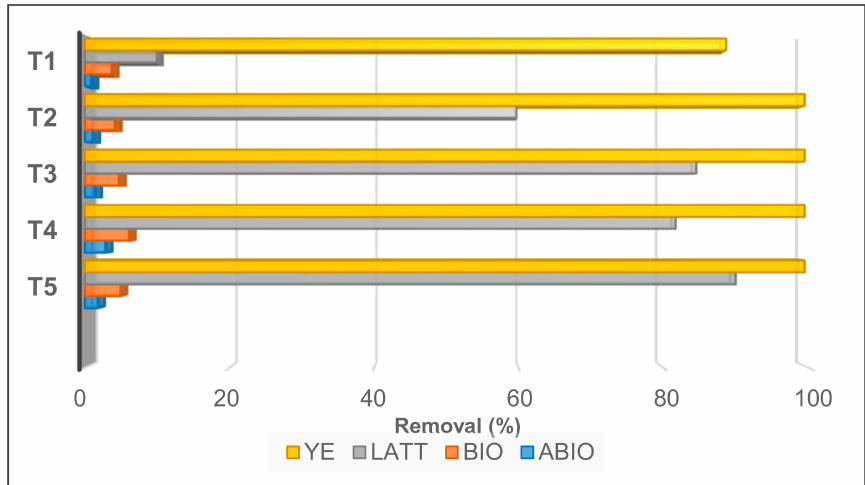
Figure 2. Percentage of Cr(VI) removal observed during di ff erent times of incubation (T1, T2, T3, T4, and T5) in microcosm tests setup in di ff erent experimental conditions (YE, LATT, BIO, and